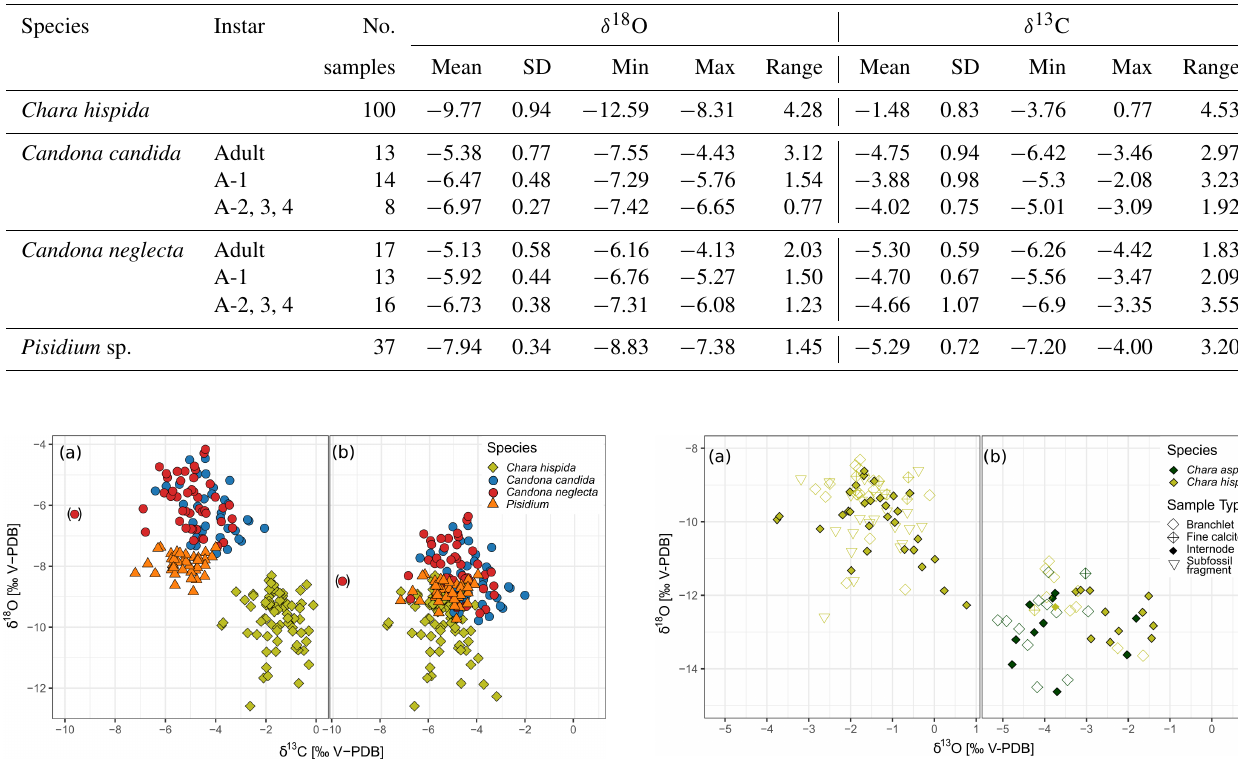
Figure 6. Isotopic composition of specific biogenic carbonate sam- ples collected from living organisms and from subfossil remains in surface sediments of Lake Locknesjön. (a) δ 18 O and δ 13 C of calcite encrustations from Chara hispida and of valves from Candona can- dida , Candona neglecta and Pisidium . (b) The same data with pub- lished vital offsets corrected for: δ 13 C Chara hispida : − 4‰ (value from Hammarlund and Keen, 1994), δ 18 O ostracods: − 2 . 2‰, δ 18 O Pisidium : − 0 . 9‰ (values from von Grafenstein et al., 1999b). The data point marked in brackets was identified as a major outlier and left out from further analysis and figures.